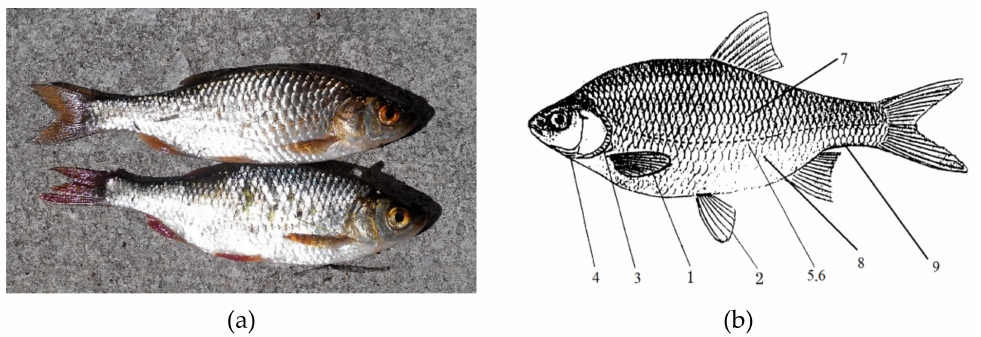
Figure 2. ( a ) appearance of caught common roach; ( b ) diagram of meristic features of fish. Adapted with permission from Ref.